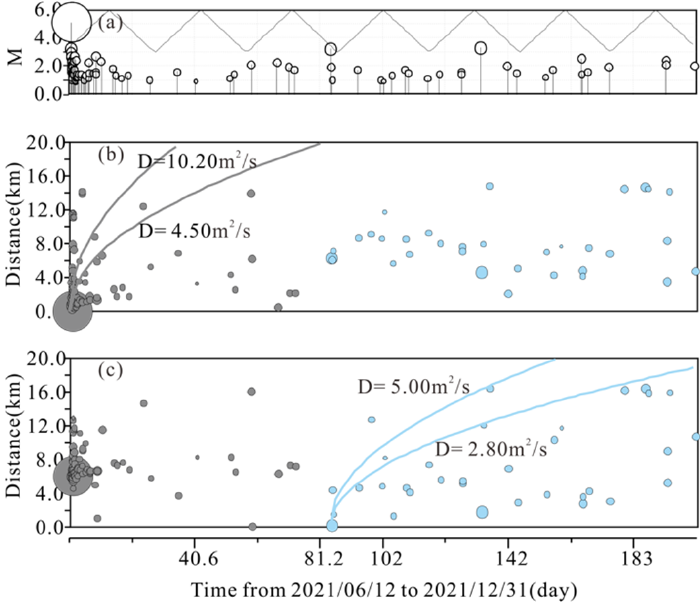
Figure 9. Distribution of aftershock sequences. The large gray circle represents the M S 5.0 mainshock, and the small gray and blue circles represent the aftershocks. The gray and blue curves are the corresponding diffusion fronts under the calibrated hydraulic diffusivity (D). ( a ) The distribution of aftershock magnitude with time. ( b , c ) The distribution of the relative distance of the aftershock sequence with time.